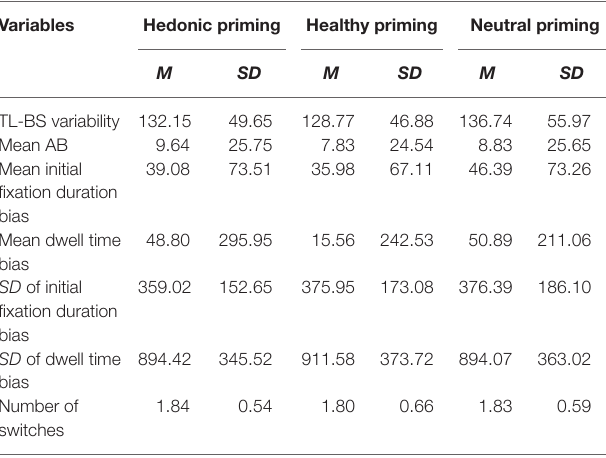
TABLE 3 | Measures of AB per priming condition. Variables Hedonic priming